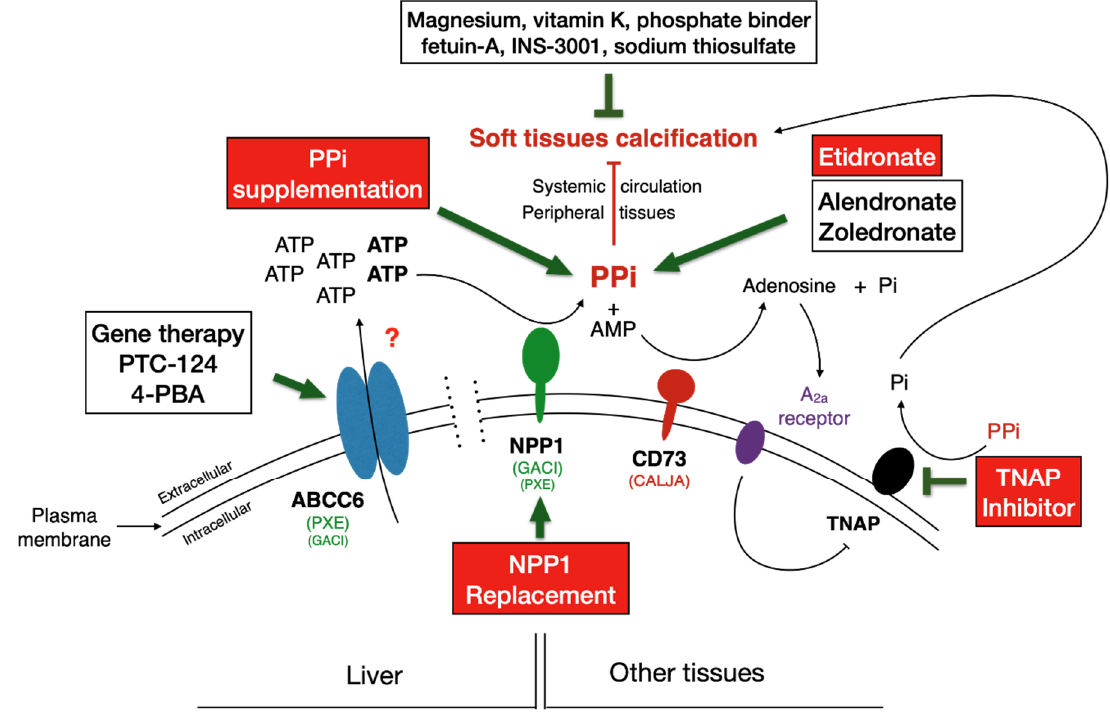
Figure 3. Tested therapeutic Interventions targeting different steps in the ABCC6 pathway to prevent calcification in PXE/GACI. Red boxes point to approaches that were tested in preclinical models and that are currently under human evaluation/trials.